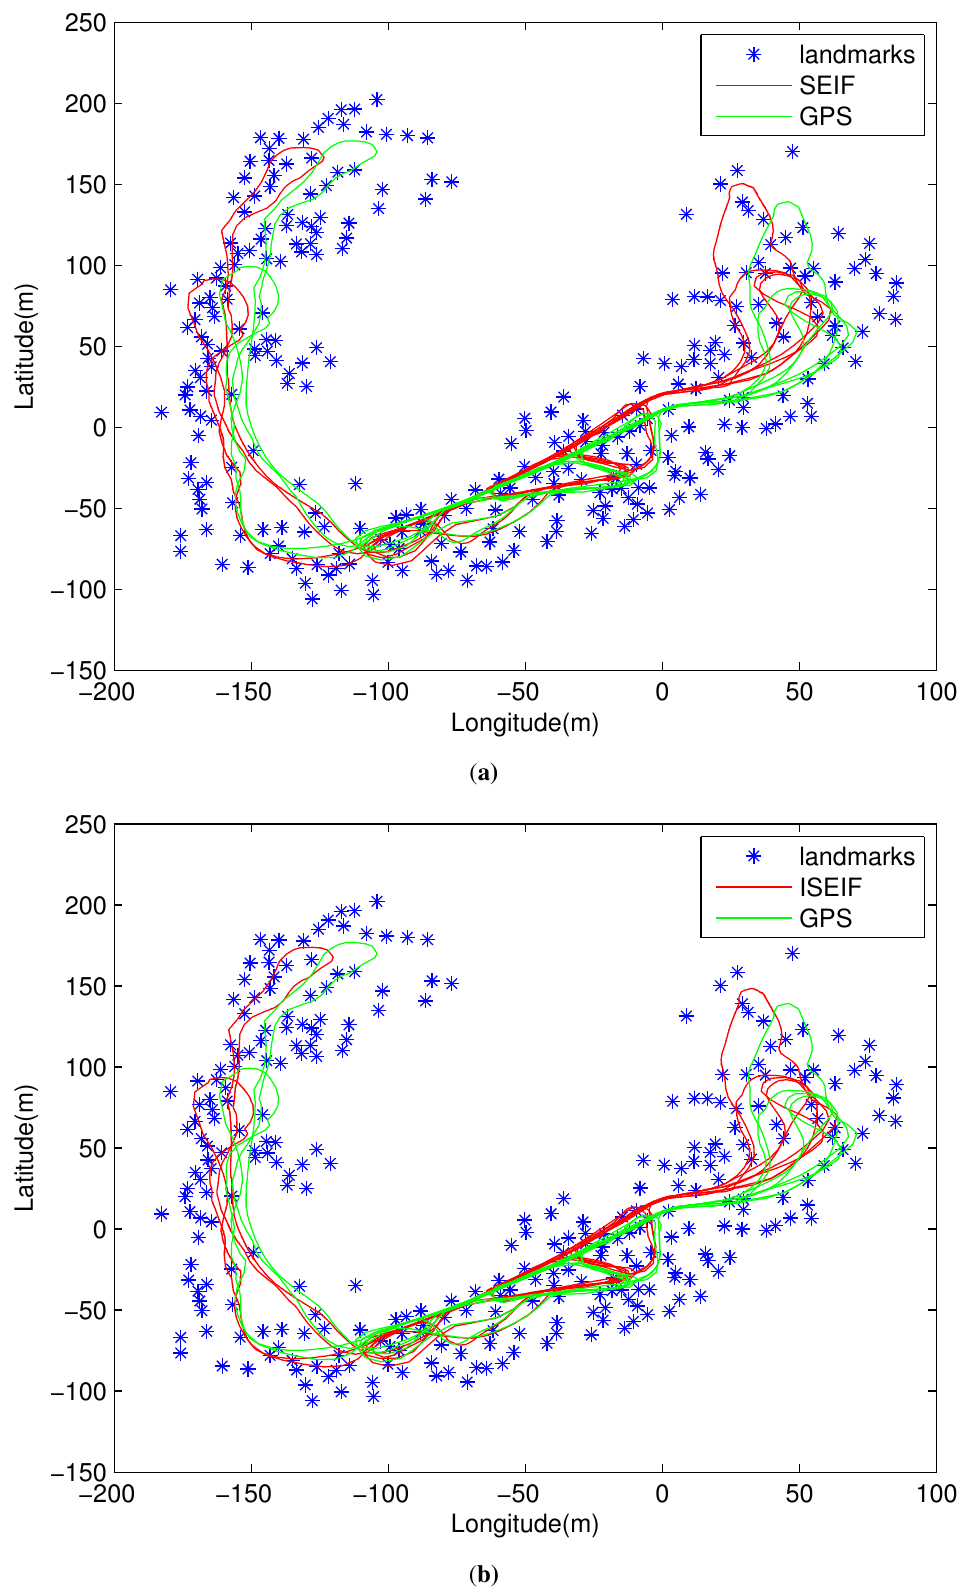
Figure 7. Estimates of the vehicle trajectories and landmarks for the Victoria Park dataset generated by the SEIF ( a ) and the ISEIF ( b